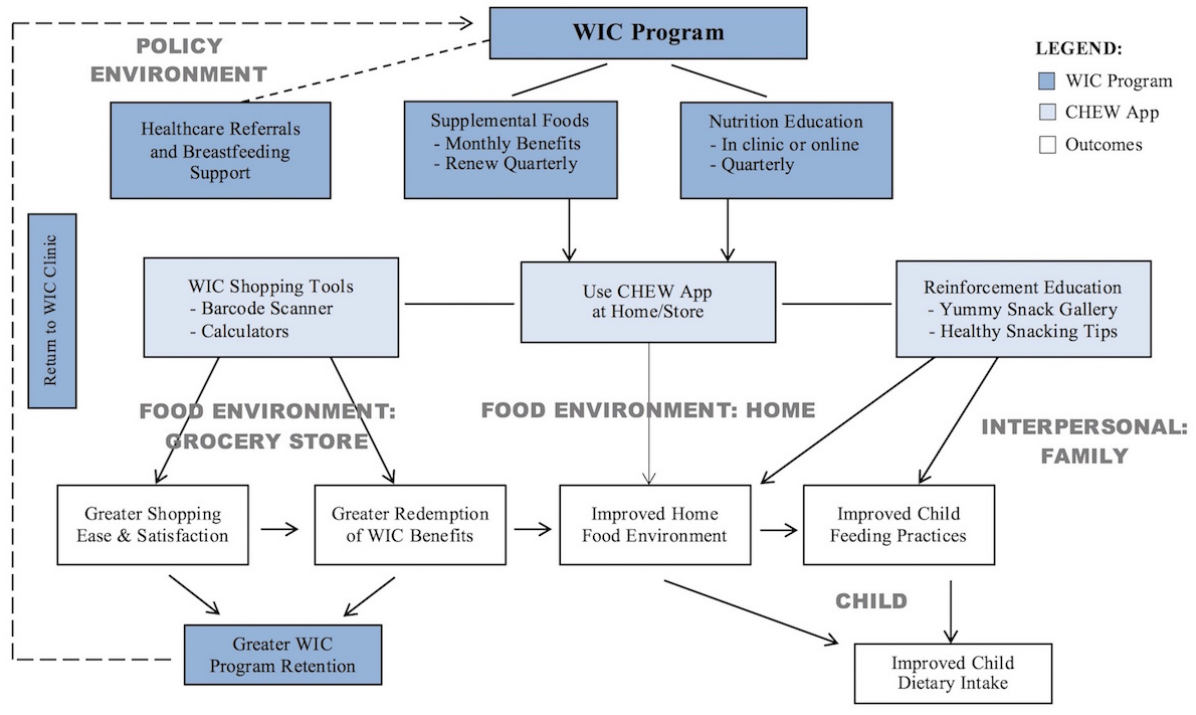
Figure 1. Conceptual model for Children Eating Well smartphone app based on socioecological framework.